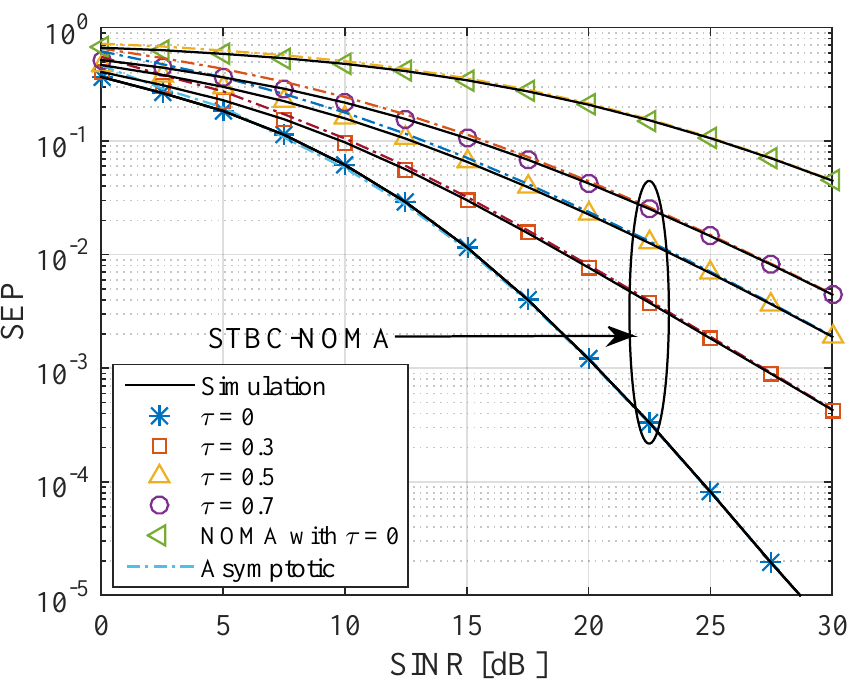
Figure 3. Symbol error probability of STBC-NOMA with U = 4 for perfect SIC and different values of timing offset ( τ ).